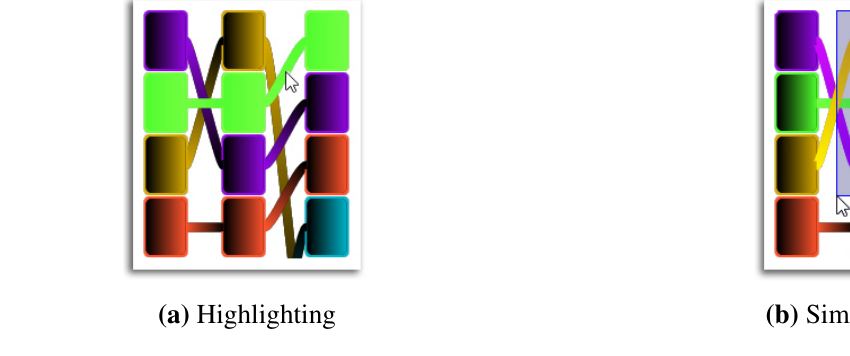
Through the adjusted visualization, we are able to make trend estimations via highlighting. An example where we highlight the green-colored feature (the number of overcome players) can be seen in ( a ). On further exploration, one may decide